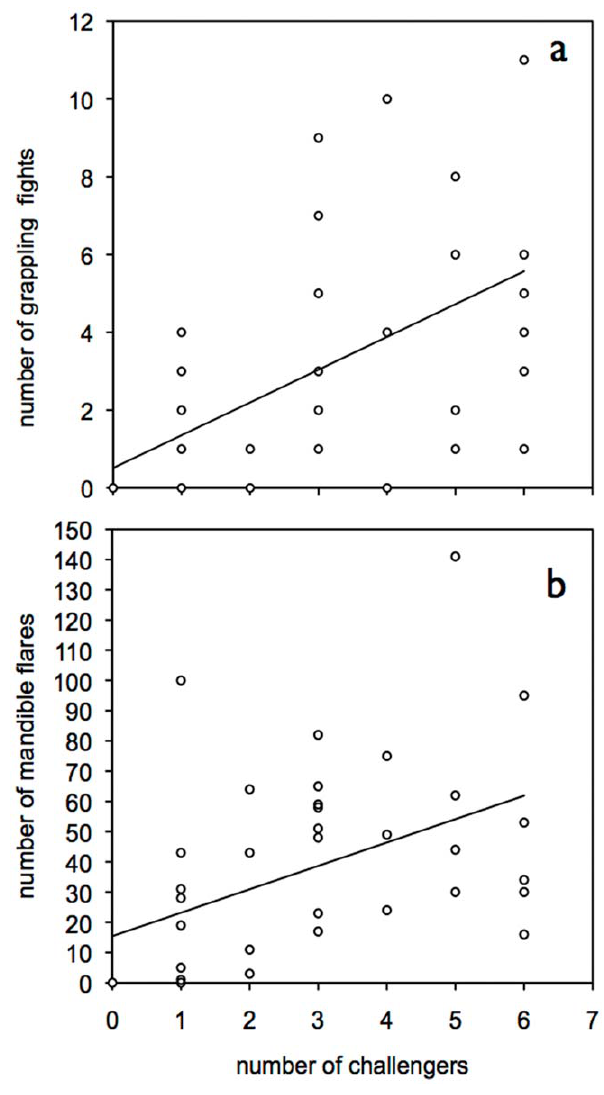
Figure 2. Trends in chameleon grasshopper agonistic interac- tions. Panel (a) shows that the number of grappling bouts between males increases with the number of males present (outlier removed) (with line of best fit). Panel (b) shows that defenders flare mandibles more often as the number of challengers increases (with line of best fit).